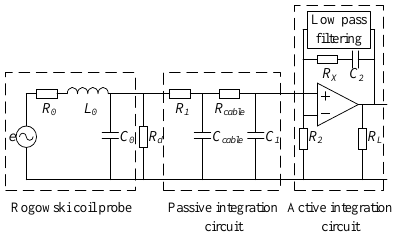
Figure 5. Lumped parameter model of the Rogowski transducer.